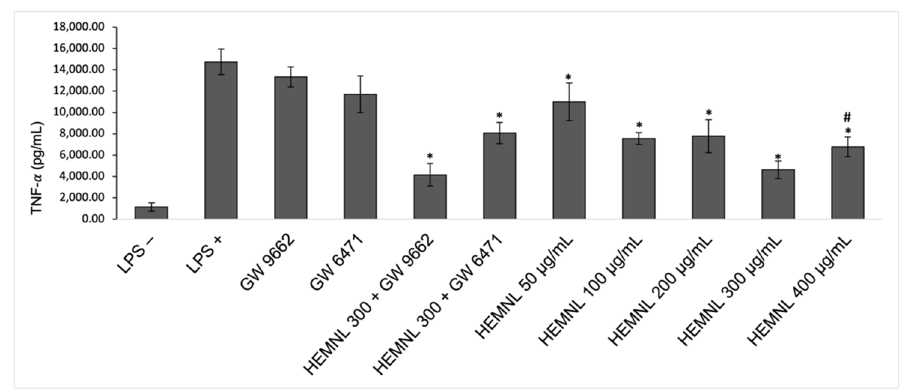
Figure 8. Reduction of tumor necrosis factor α (TNF- α ) production in lipopolysaccharide (LPS)- stimulated RAW 264.7. LPS +: positive control—cells stimulated with LPS and treated with vehicle (DMEM with 2% of ethanol). LPS –: negative control—cells not stimulated with LPS and treated with vehicle. HEMNL: Hydroethanolic Extract of Morus nigra leaves. Data represent mean ± standard deviation. Statistical analysis was performed by one-way ANOVA test followed by Tukey’s post-test. * p < 0.023 in relation to LPS +; # p = 0.047 in relation to HEMNL 300 + GW 6471.